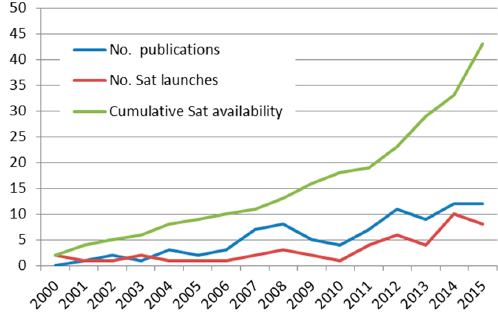
Figure 1. Number of publications on slums and remote sensing methods by year and successfully launched VHR satellites (r 2 is 0.75).